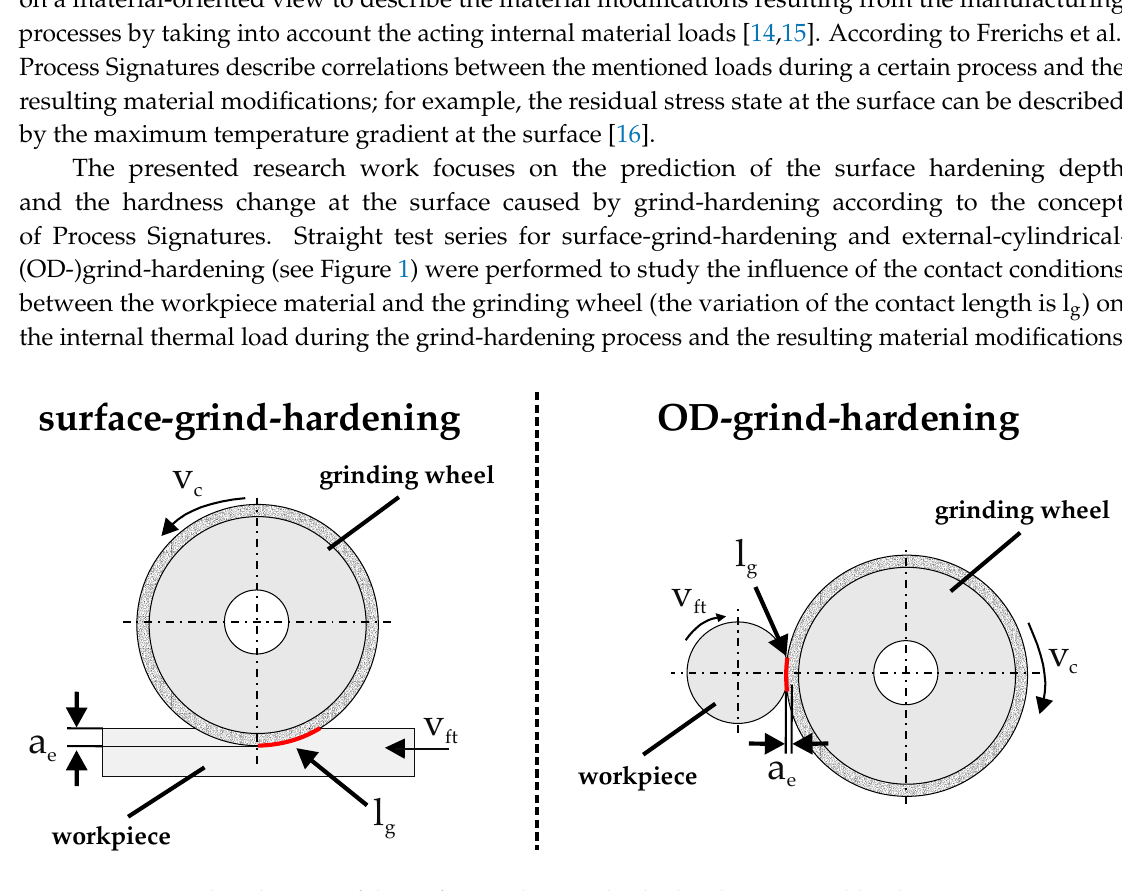
Figure 1. The schematic of the surface- and external-cylindrical-(OD-) grind-hardening process.